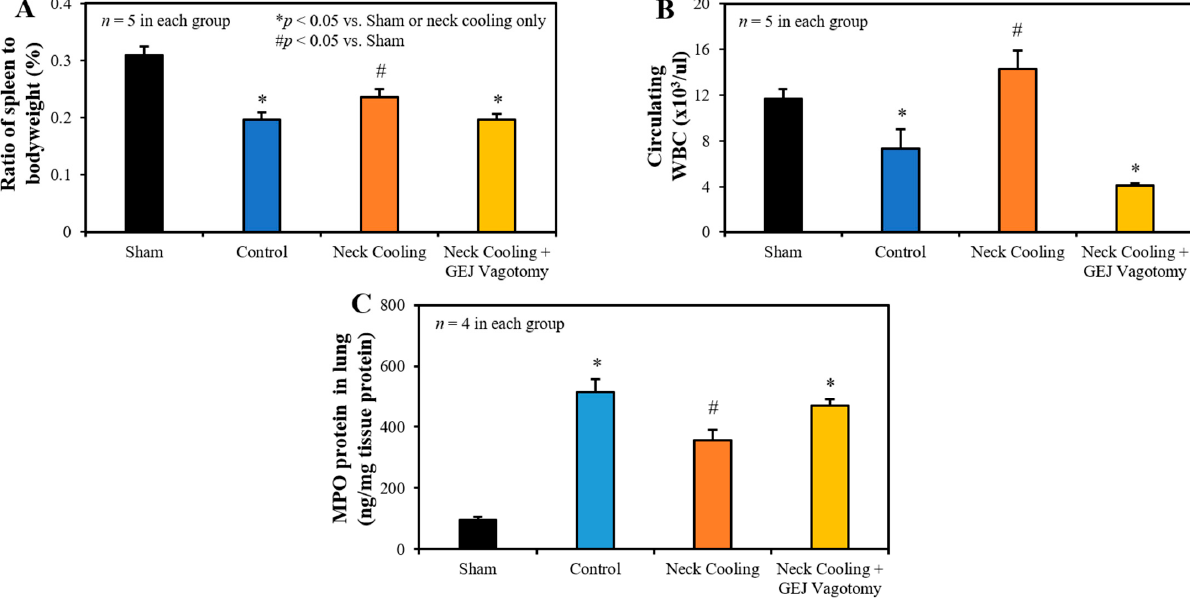
Figure 5. Kaplan–Meier survival curves after CLI without peritoneal washout ( A ) and with washout ( B ). NC: Neck cooling.